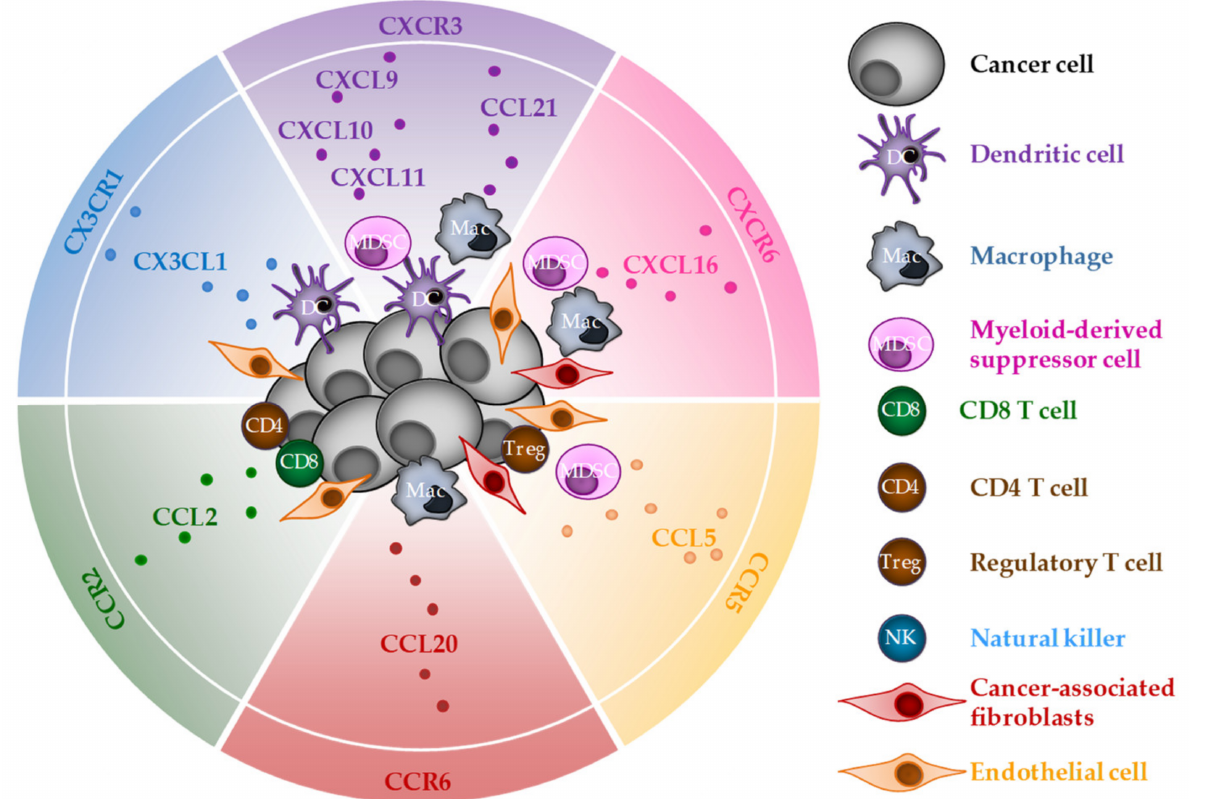
Figure 2. Chemokines and chemokine receptors that may be involved in CD8 T-cell chemoattraction during ICD. Cells in the tumor microenvironment and cancer cells (at the center) able to secrete chemokines and corresponding receptors (at the periphery) expressed by CD8 T